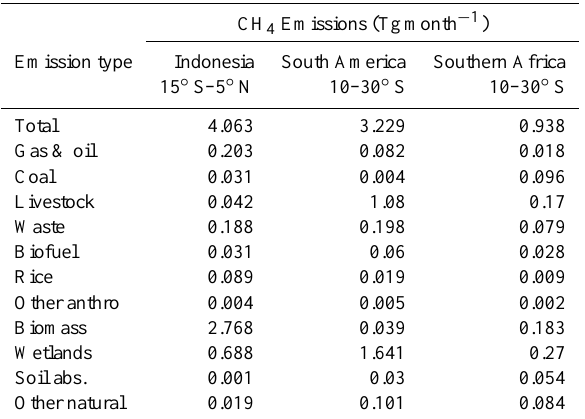
Table 2. CO emissions used for GEOS-Chem model estimates for October